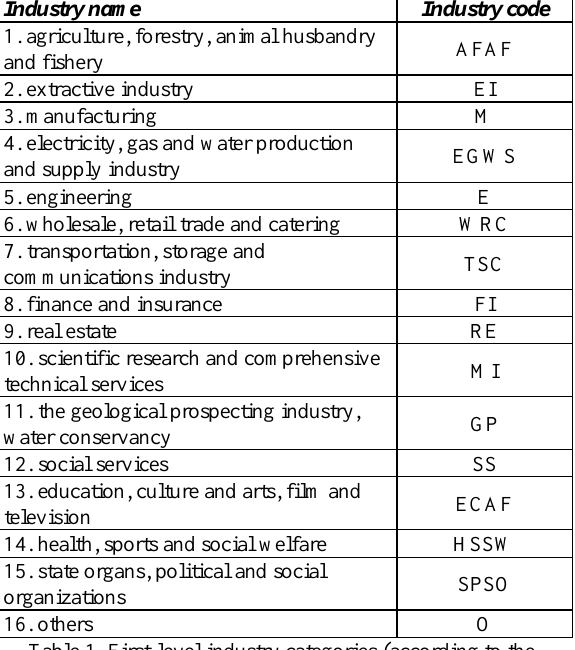
Table 1. First-level industry categories (according to the National Economic Industry Classification Standard of